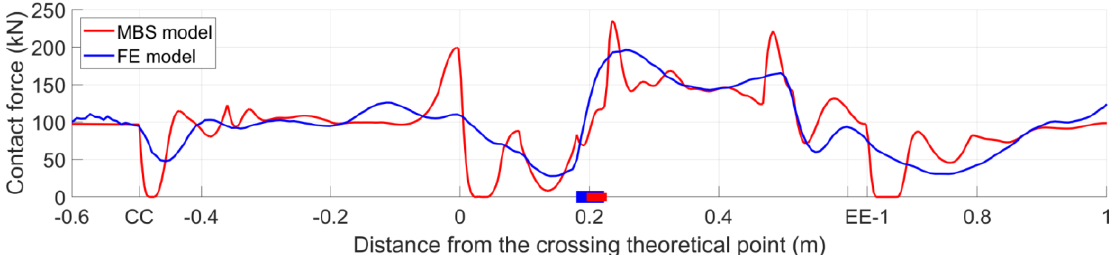
Figure 19. Comparison of the vertical wheel − rail contact forces.